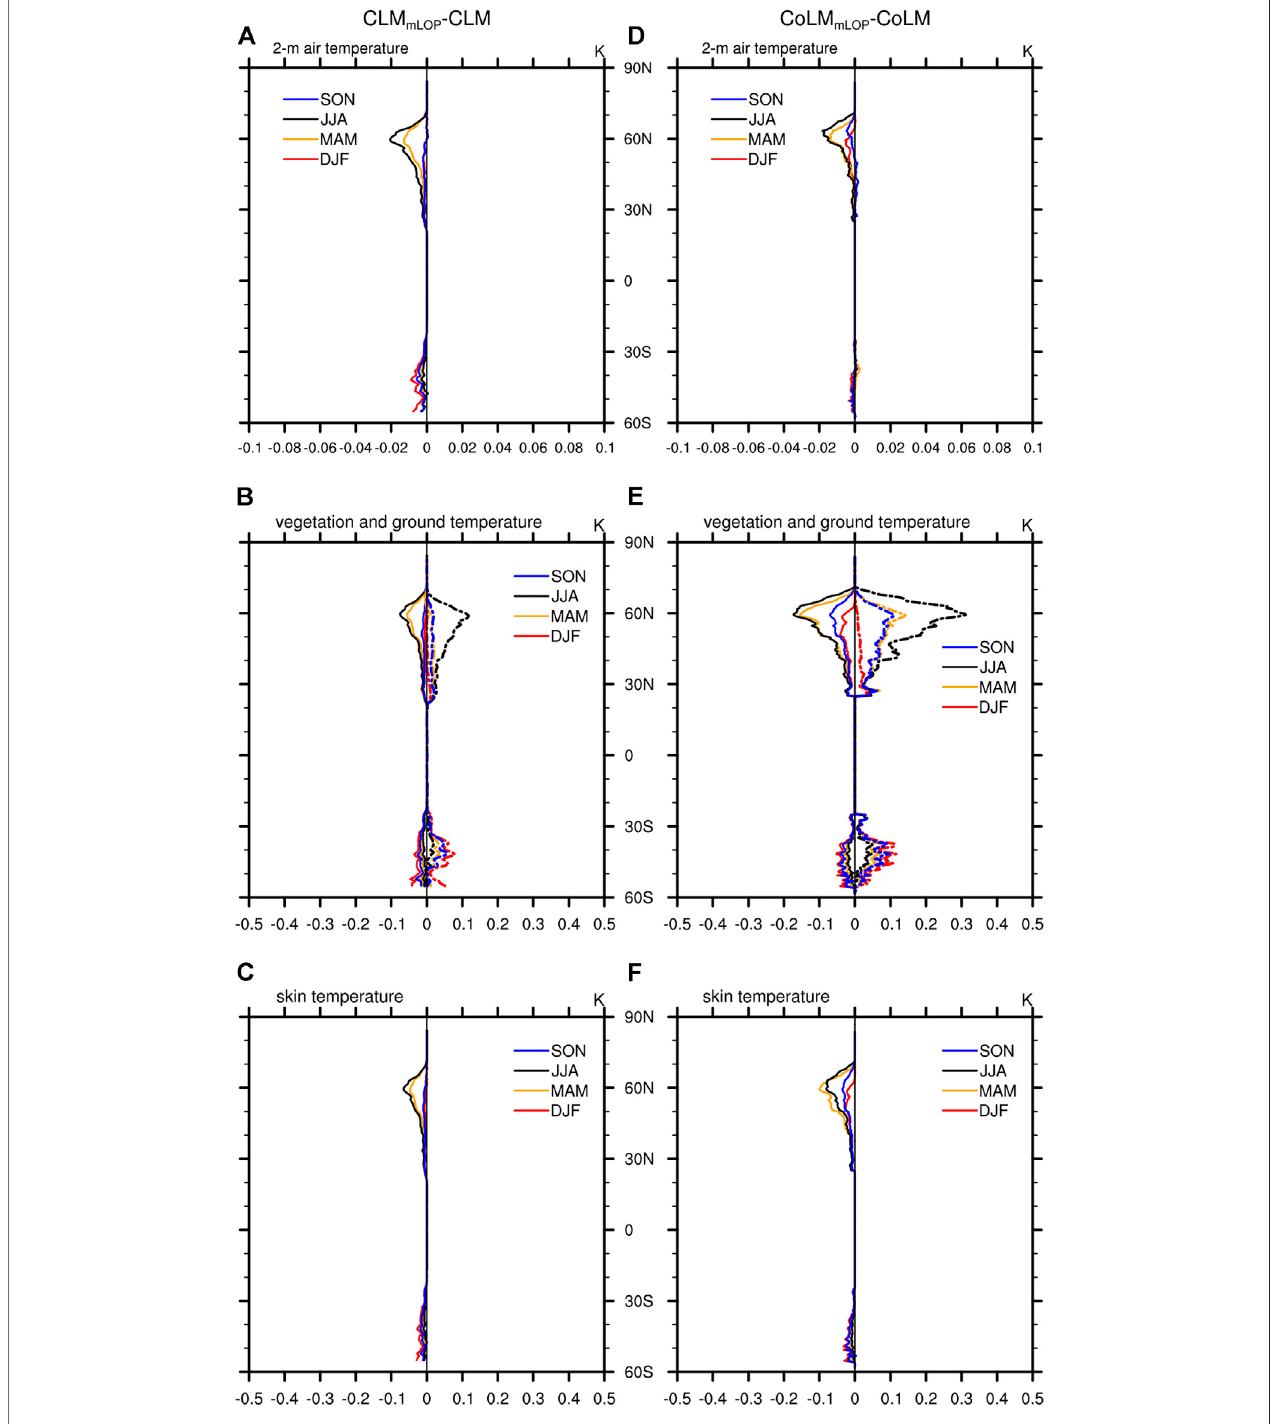
FIGURE 9 | Zonal average differences in 2-m air temperature (A,D) , vegetation (ground) temperature (B,E) and skin temperature (C,F) between CLM (CoLM) and CLM_mLOP (CoLM_mLOP). The solid line and dashed line in (B,C,E,F) represent vegetation and the ground, respectively.